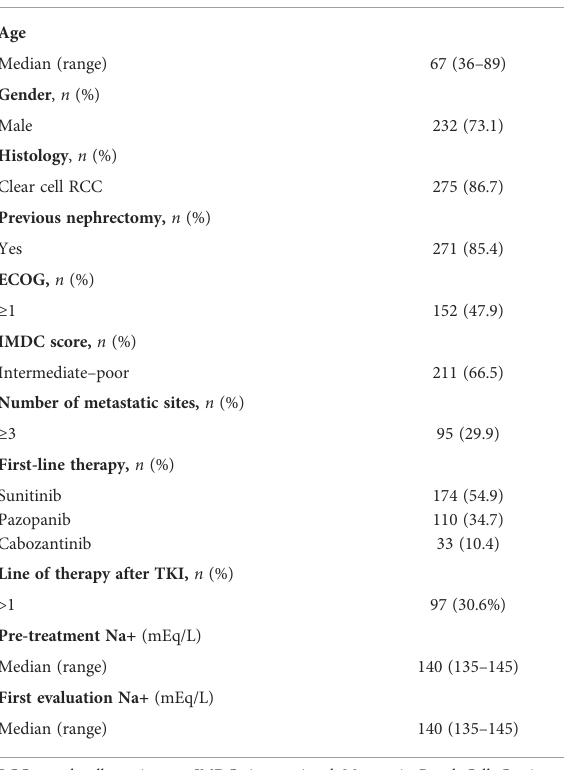
TABLE 1 Patients ’ baseline